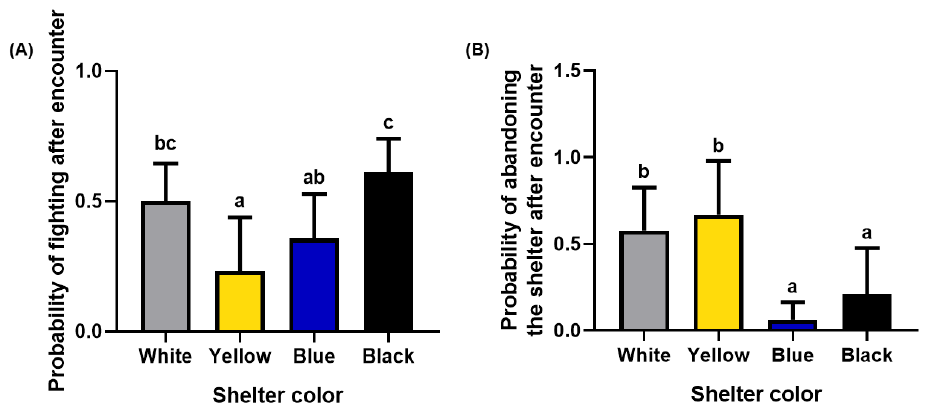
Figure 8. The probability of fighting after an encounter ( A ) and the probability of abandoning the shelter after an encounter ( B ). Different lowercase letters represent statistically significant differences in encounter behavior ( p < 0.05).